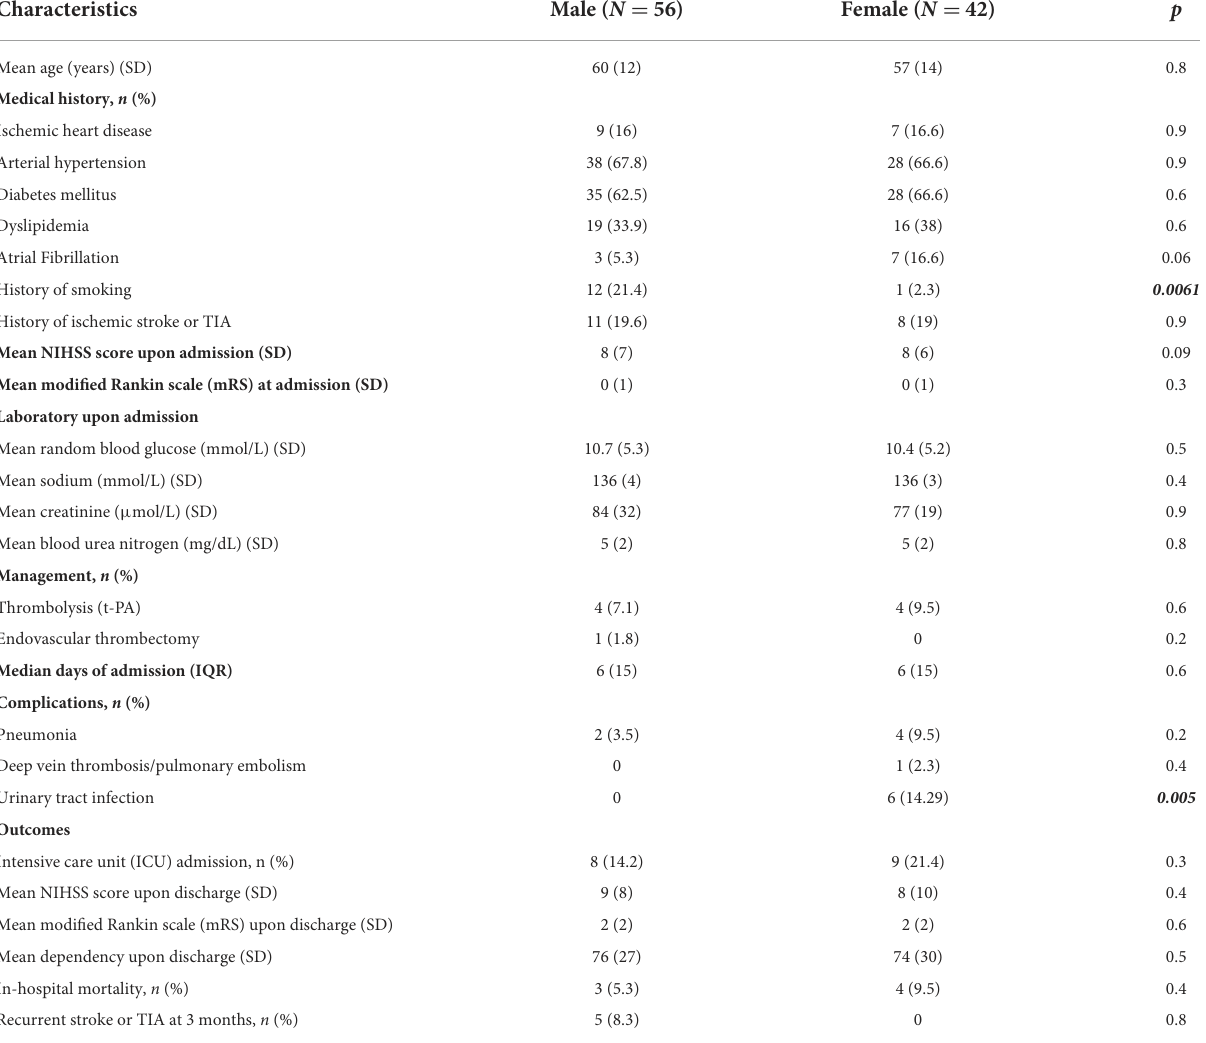
TABLE 3 Clinical characteristics and outcomes of ischemic stroke (IS) patients during Ramadan months based on gender. Characteristics Male ( N =